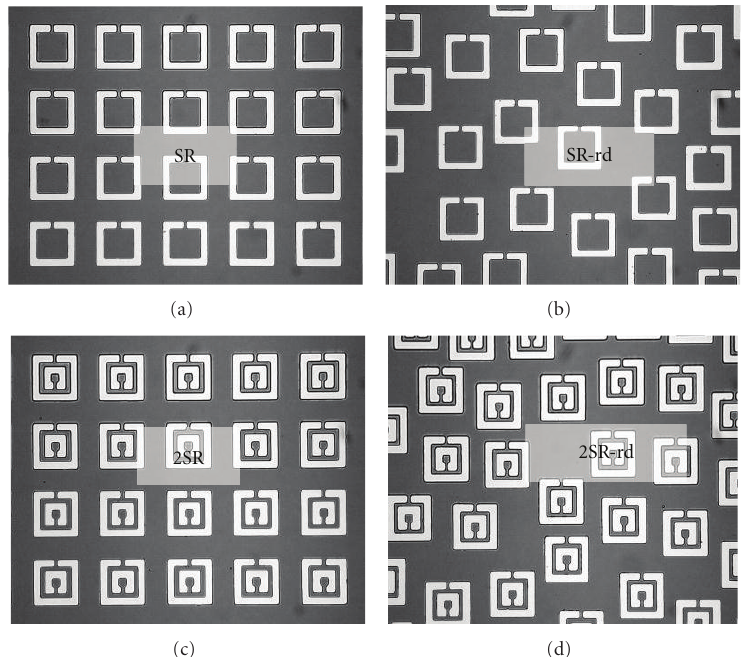
Figure 8: Microscopic images of the (a) periodic and (b) random single SRR array, (c) periodic and (d) random double SRR array. The dimensions of the outer ring are the same as in Figure 5 and of the inner smaller ring are the same as in Figure 4(a). arrangement, all spectra show a strong resonance at 1.33 THz and have nearly the same spectral dependence. Exactly the same observation is made in the simulation. This resonance is the lowest-order even